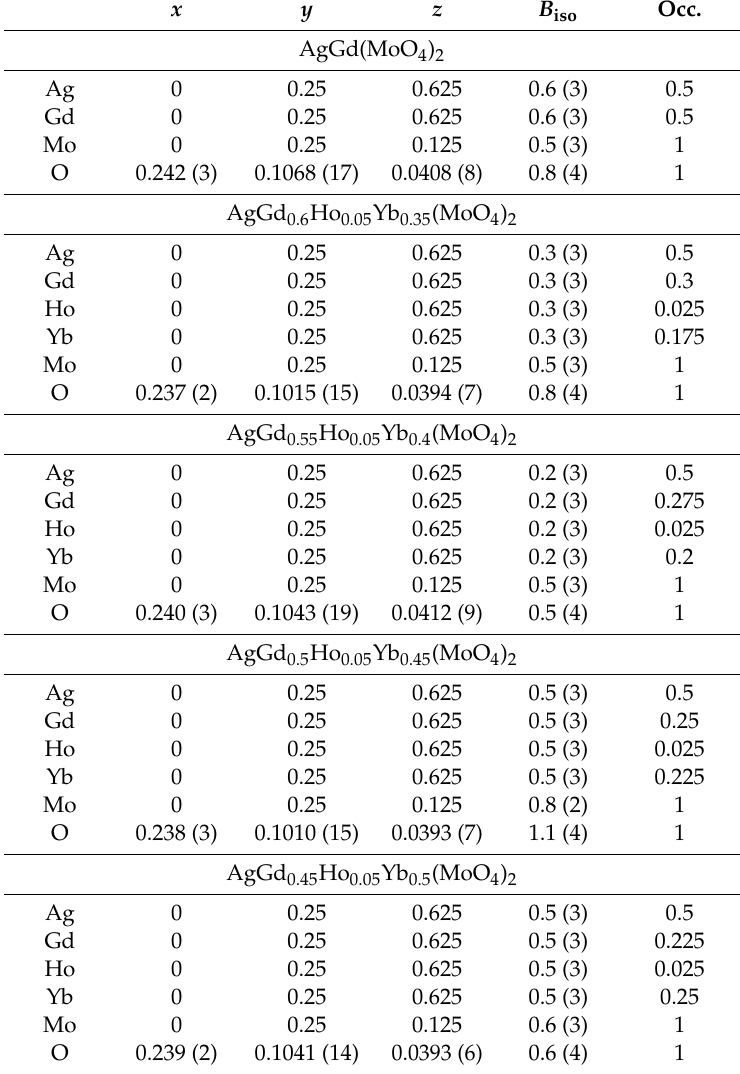
Table 2. Fractional atomic coordinates and isotropic displacement parameters (Å 2 ) of